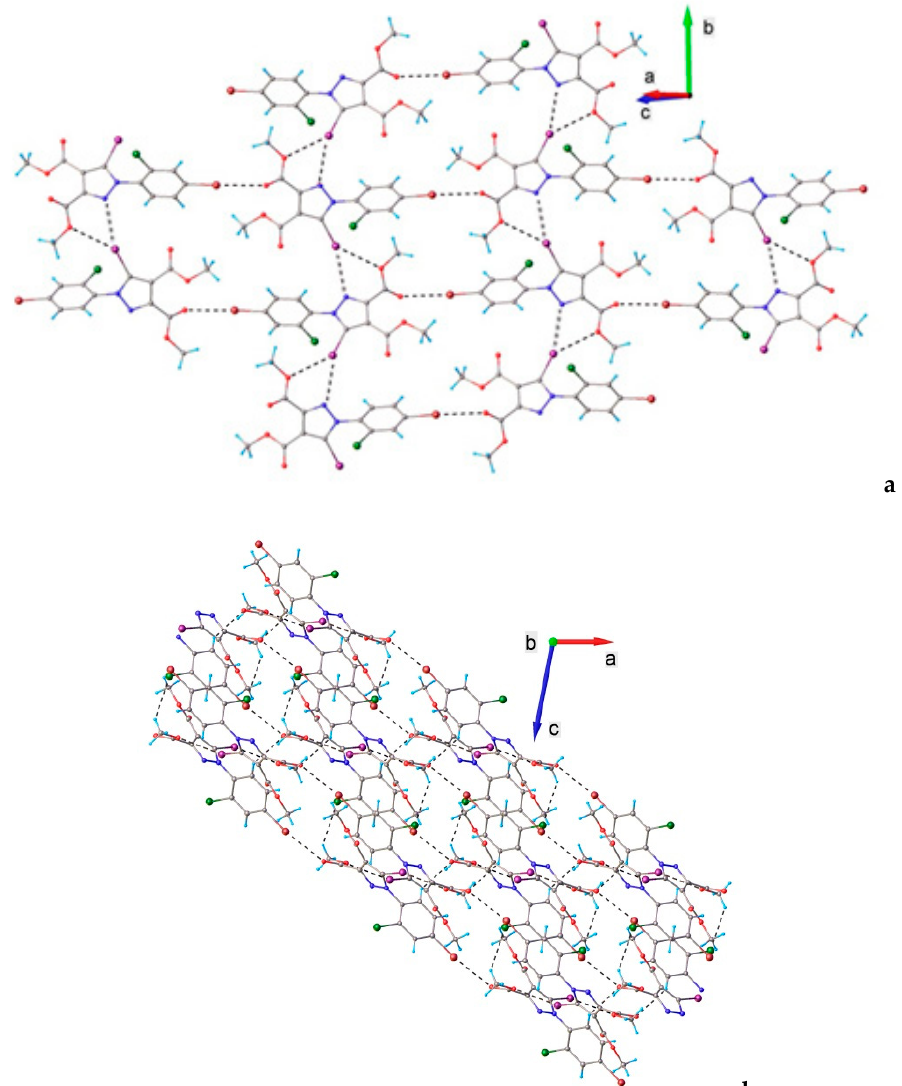
Figure 11. ( a ) The formation of a 2D supramolecular layer in the crystal structure of 6 . Halogen bond parameters: C7-I1···O2 [I1···O2(2 − x , y − 0.5, 1.5 − z ) 3.230(5), ∠ C7I1O2 146.1(2)°]; C1-Br···O1 [Br1···O1( x